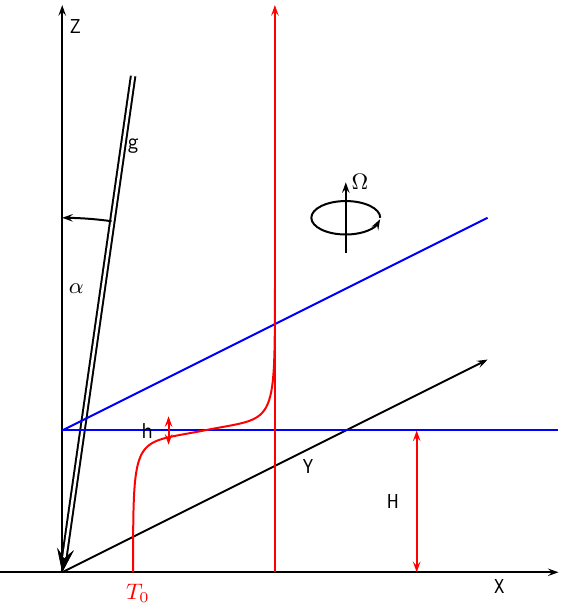
Fig. 1. Initial condition: A layer of cold (dense) water of thickness H superposed by warmer (less dense) water on an inclined plane of angle α in a rotating frame with frequency (cid:127) . The interface (blue Fig. 11. Initial condition: A layer of cold (dense) water of thickness H superposed by warmer (less dense) water on an inclined plane of line) has a thickness h. The temperature anomaly is indicated by angle α in a rotating frame with frequency Ω . The interface (blue line) has a thickness h. The temperature anomaly is indicated by the red the red line. Please note the tilt by an angle α of the direction of line. Please note the tilt by an angle α of the direction of gravity with respect to the z -direction. The gravity vector is in the x − z -plane. gravity with respect to the z-direction. The gravity vector is in the